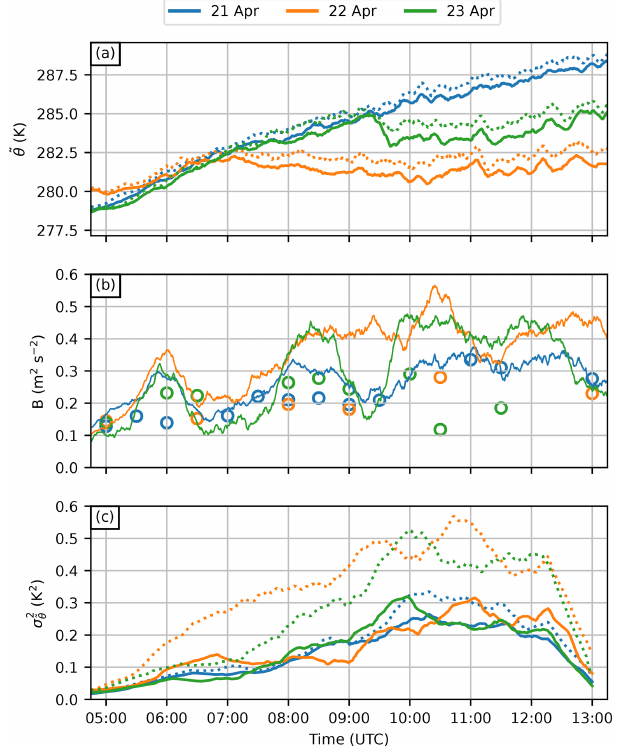
Figure 12. An overview of convective boundary layer development on 21–23 April 2020. (a) Time series of ˜ θ estimated from the DTS system from two heights, 28m (solid lines) and 6m (dotted lines). (b) Column-integrated buoyancy observed using the DTS system (solid lines) and predicted using MOST (circles). Some of the pre- dictions are missing due to flux stationarity screening performed on the EC data. (c) Wavelet-estimated localised variance estimates for 28m (solid lines) and 6m (dotted lines). Ten-minute moving- average smoothing has been applied to the data in all panels.